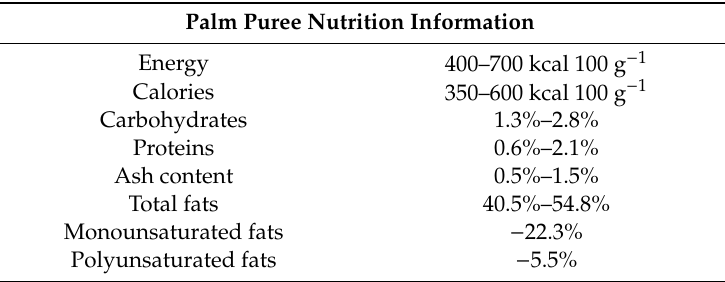
Table 1. Nutritional composition of palm puree water extract